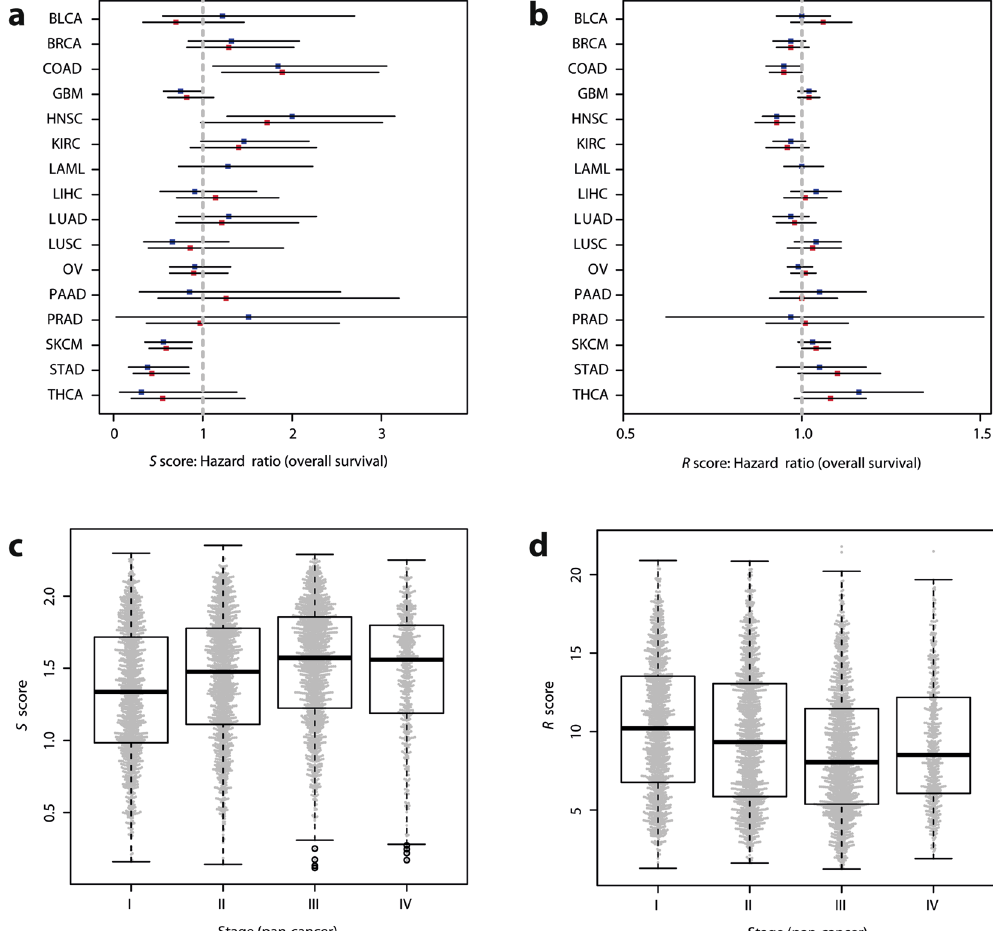
Figure 5. Relationships of the S and R scores with survival and stage in real cancer data. ( a , b ) Hazard ratios and confidence intervals for overall survival Cox proportional based on the S score ( a ) and R score ( b ) for all cancer types. Blue squares correspond to overall survival and red squares to relapse-free survival. Squares indicate the predicted hazard ratios, horizontal black lines indicate the confidence intervals and the vertical dashed grey lines indicate a hazard ratio of 1. X-axis scales differ. ( c , d ) Distributions of the S score ( c ) and R score ( d ) per cancer stage on a pan-cancer basis (4,363 samples with stage and survival information). Gray dots represent each individual sample. Both p < 0.001 (independence